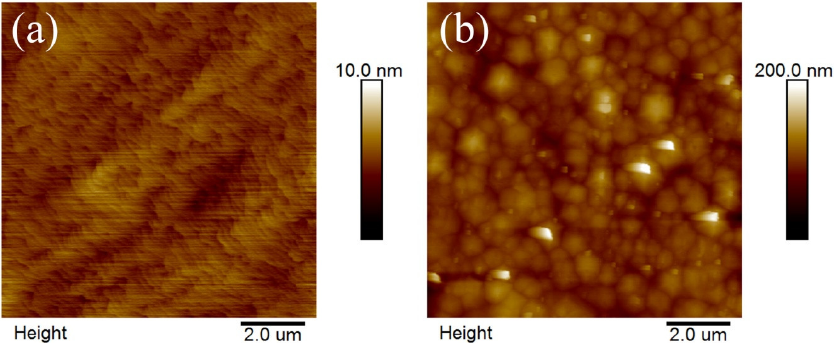
Figure 2. AFM surface morphology of planar III-polar ( a ) and N-polar ( b ) MQW samples.